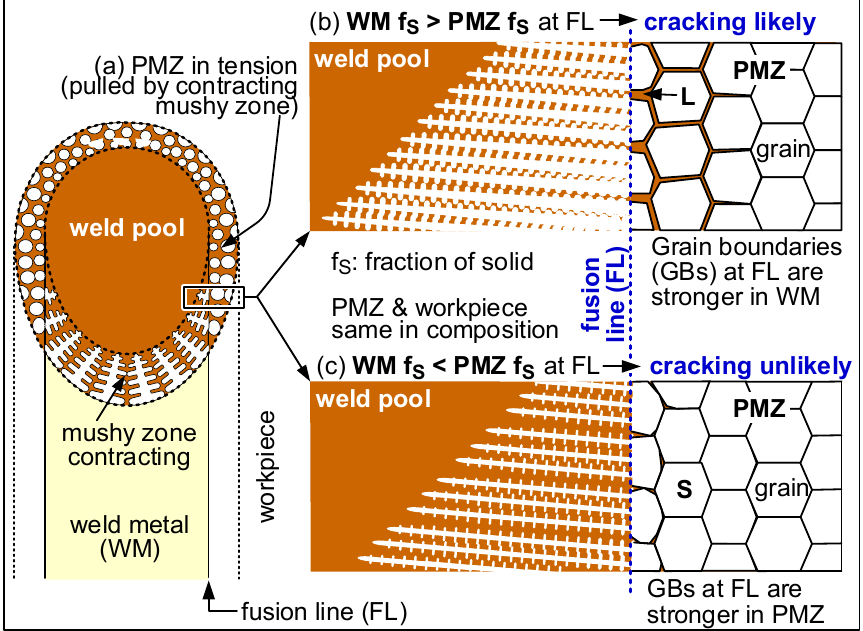
Figure 3. Criterion for liquation cracking at weld edge (fusion line): ( a ) schematic microstructure; ( b ) susceptible; ( c ) not susceptible.